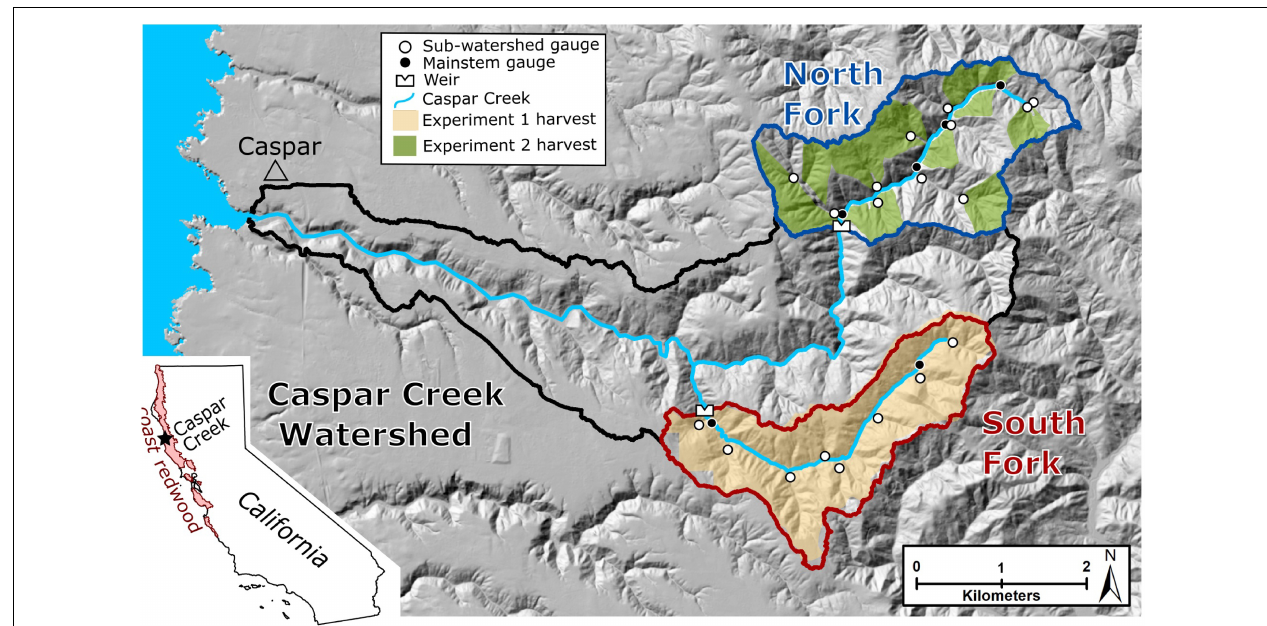
FIGURE 1 | Shaded relief map showing the Caspar Creek Experimental Watersheds and the surrounding region. The inset map shows the location of Caspar Creek and the modern extent of coast redwood. The harvest for the First Experiment was from 1971 to 1973 and the harvest for the Second Experiment was from 1989 to 1992. The weirs were installed in 1962 and have been continuously operational. Installation of the North Fork sub-watershed gages began in 1984. South Fork sub-watershed gages were installed in 2000. The Caspar Creek outlet is located at 39.362 ◦ N, 123.816 ◦ W. The modern extent of coast redwood boundary was supplied by Save the Redwoods League. The shaded relief map was created from LiDAR data collected in 2017 gridded to 10-m horizontal resolution.